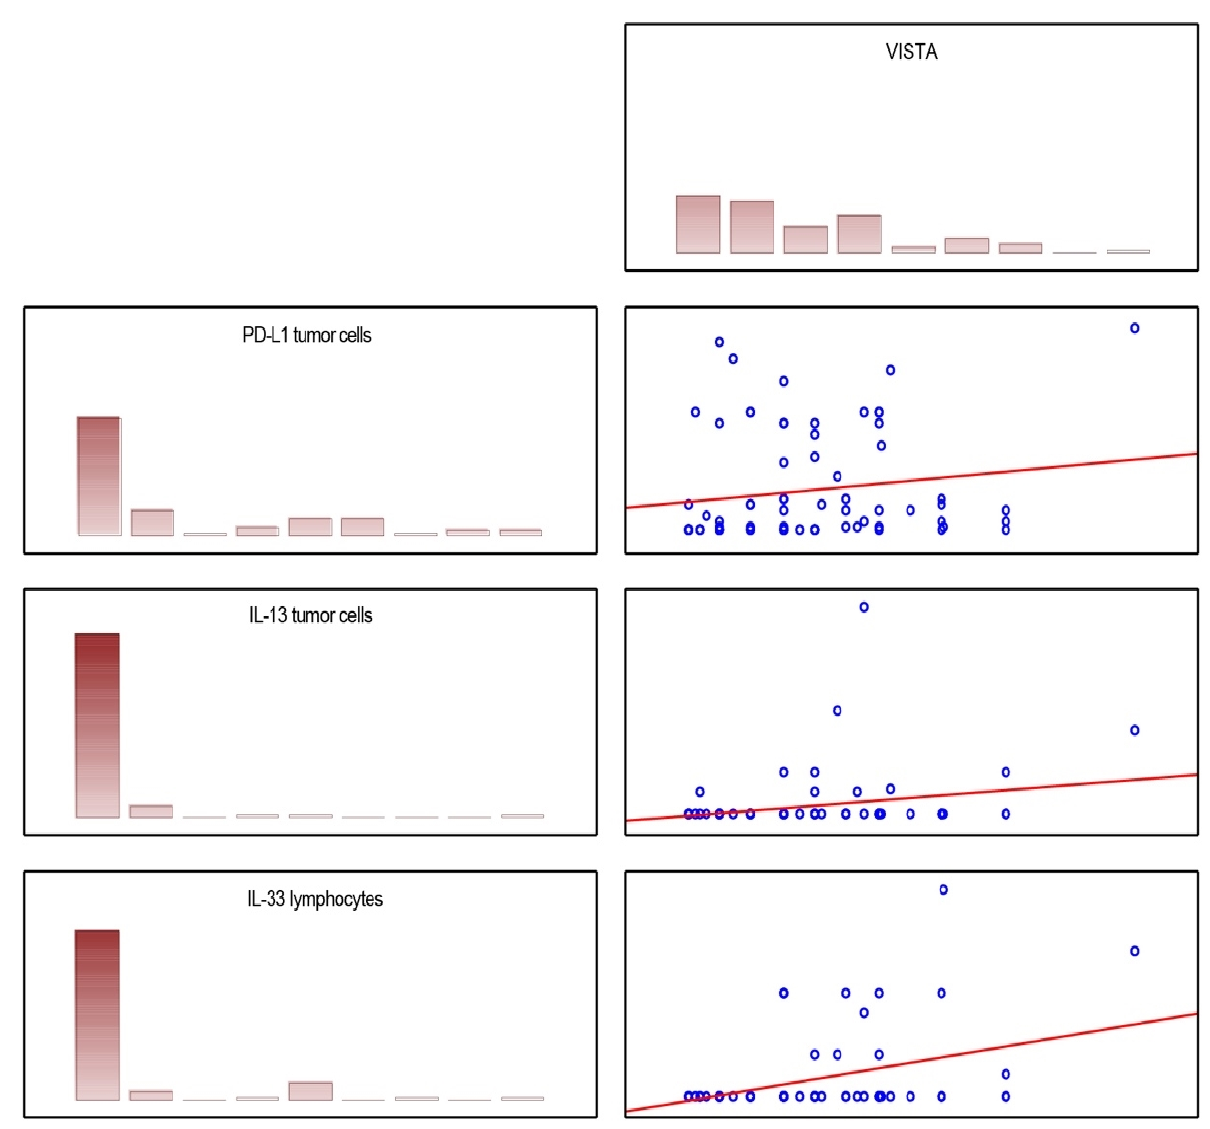
Figure 4. Scatter plot matrix describing significant correlations of VISTA with molecules analyzed in our previous studies in the same cohort.